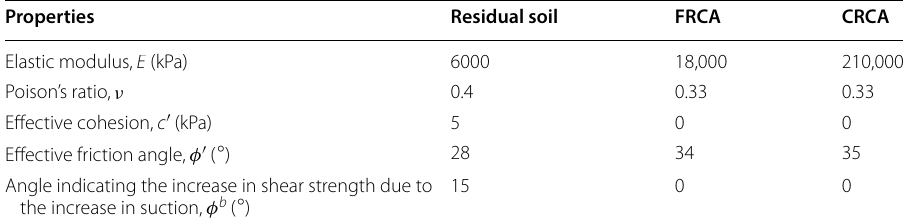
Table 4 Mechanical properties of residual soils, fine RCA, and coarse RCA Properties